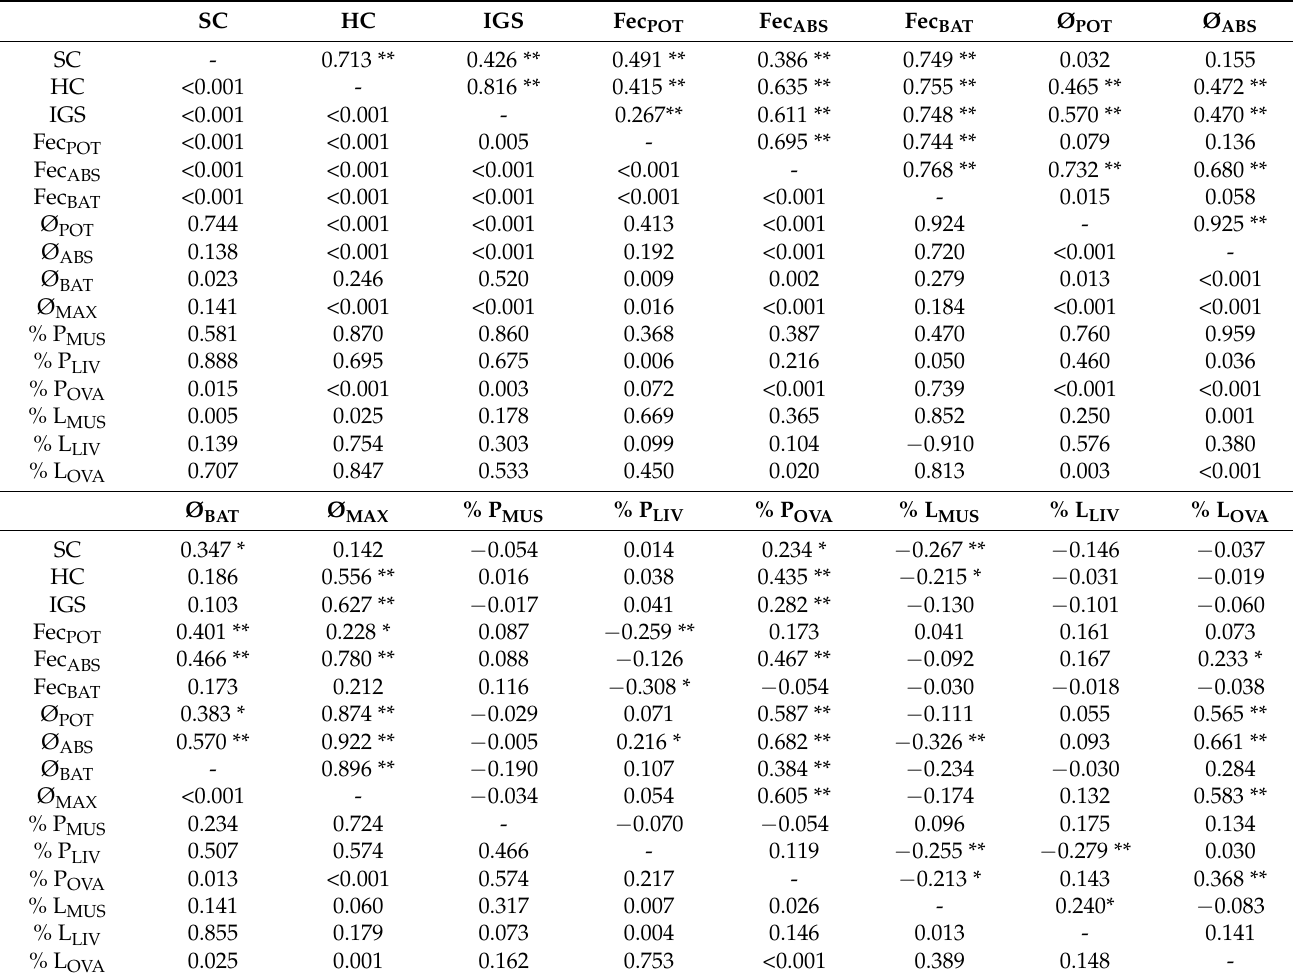
Table 5. Correlation matrix of fish somatic condition (SC), hepatosomatic condition (HC), gonad activity (GSI), fecundity, oocyte size and proteins and lipids percentages by tissues in females of Gobio lozanoi . Spearman’s coefficient above the diagonal and p -values below the